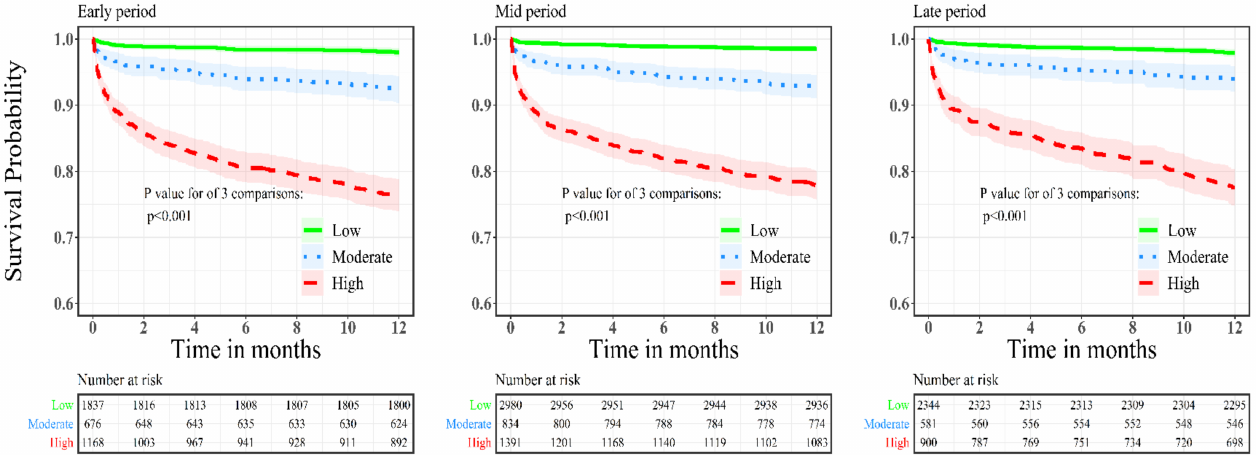
Figure 1. Kaplan–Meier curves for 1-year all-cause mortality according to bleeding risk for patients enrolled in early, mid and recent